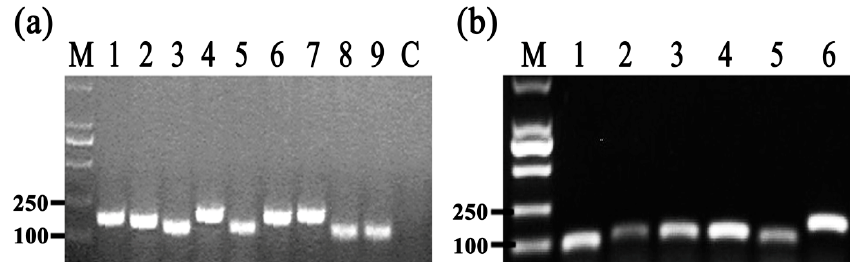
Figure 8. Results of conventional PCR for primers used in qRT-PCR assay. ( a ) M = Marker DL2000 (TaKaRa, Dalian, China); 1 = Lip; 2 = clpA; 3 = TomB; 4 = porin; 5 = protein F; 6 = ImpJ; 7 = ImpG; 8 = hcp; 9 = vgr-1; Control = distilled water (negative control); ( b ) M = Marker DL2000 (TaKaRa, Dalian, China); 1 = topB; 2 = gyrB; 3 = parE; 4 = parC; 5 = topA; 6 = gyrA.